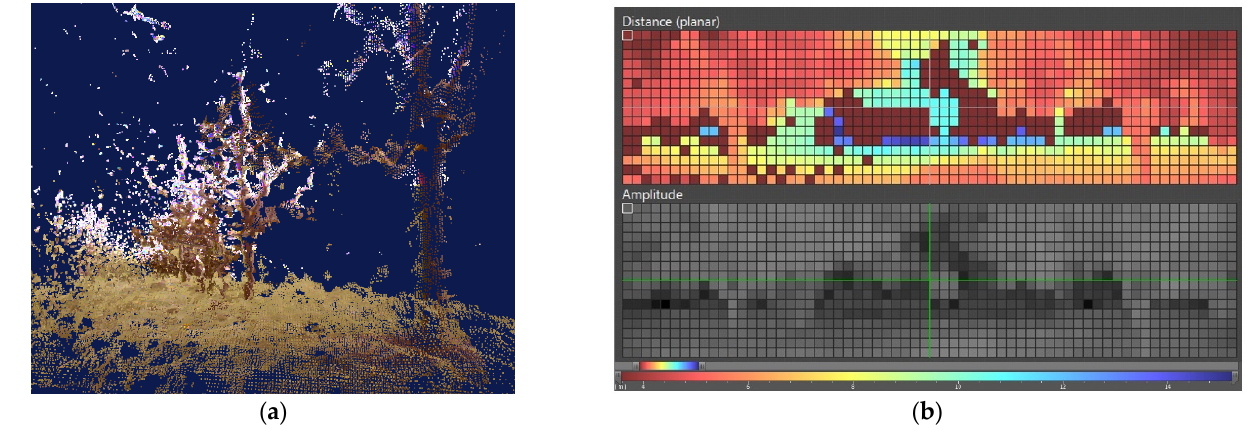
Figure 4. Canopy volume estimation from 3D point clouds: ( a ) stereoscopic vision; and ( b ) time of flight sensors.